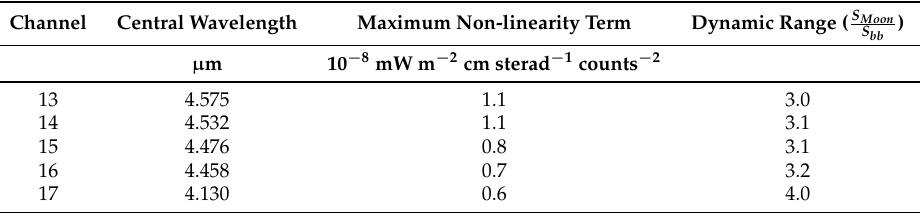
Table 6. Upper limit of the non-linearity and the ratio of flux densities received from the Moon and the black body for channels 13-17 of HIRS/4 on